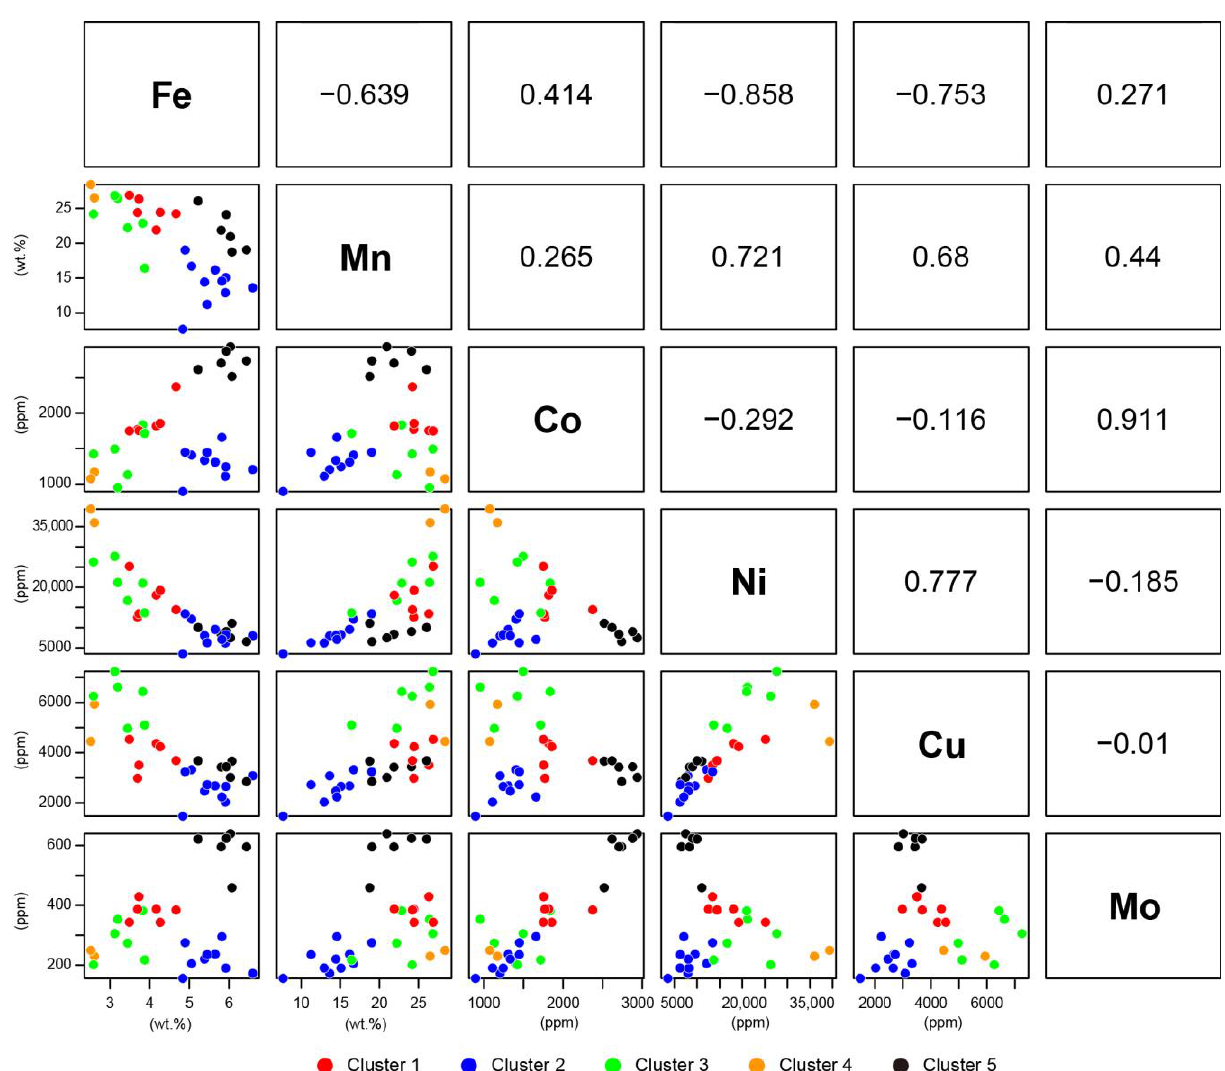
Figure 5. Scatter plot matrix of the Fe–Mn micronodule compositions. The diagonal components represent the variables used in the K -means cluster analysis. The upper panels in the matrix indicate the correlation coefficients for all data. The lower panels show two-dimensional scatter plots for each pair of variables (element contents). The color-coding of the data points is the same as that in Figure 4.